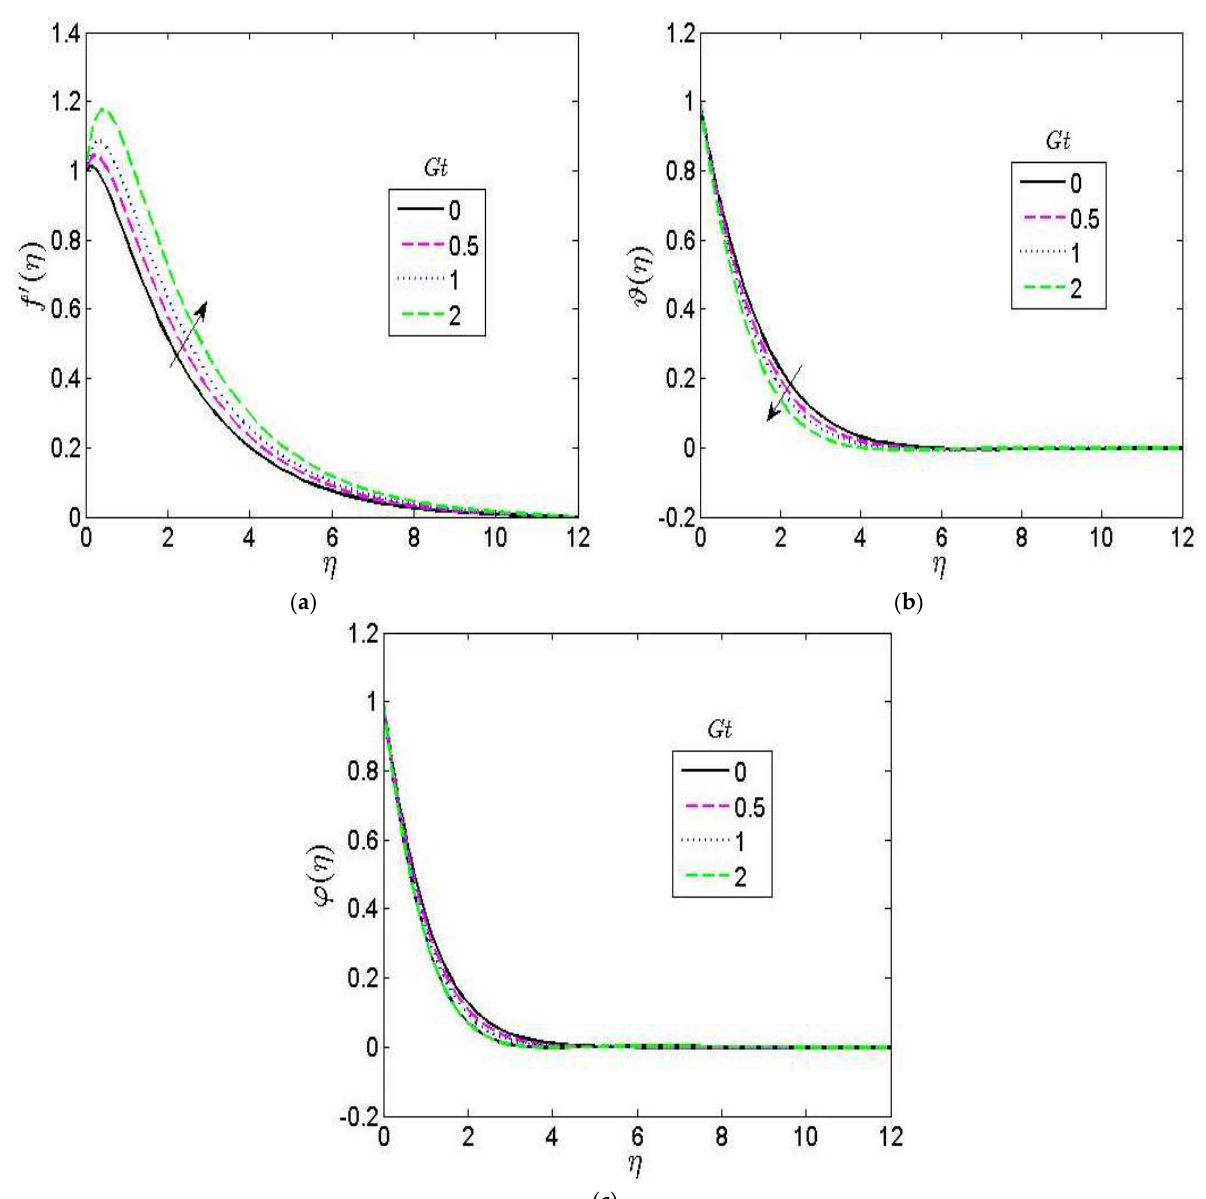
Figure 12. Effect of thermal Grashof number Gt on ( a ) velocity, ( b ) temperature, and ( c ) concentra- tion profiles.